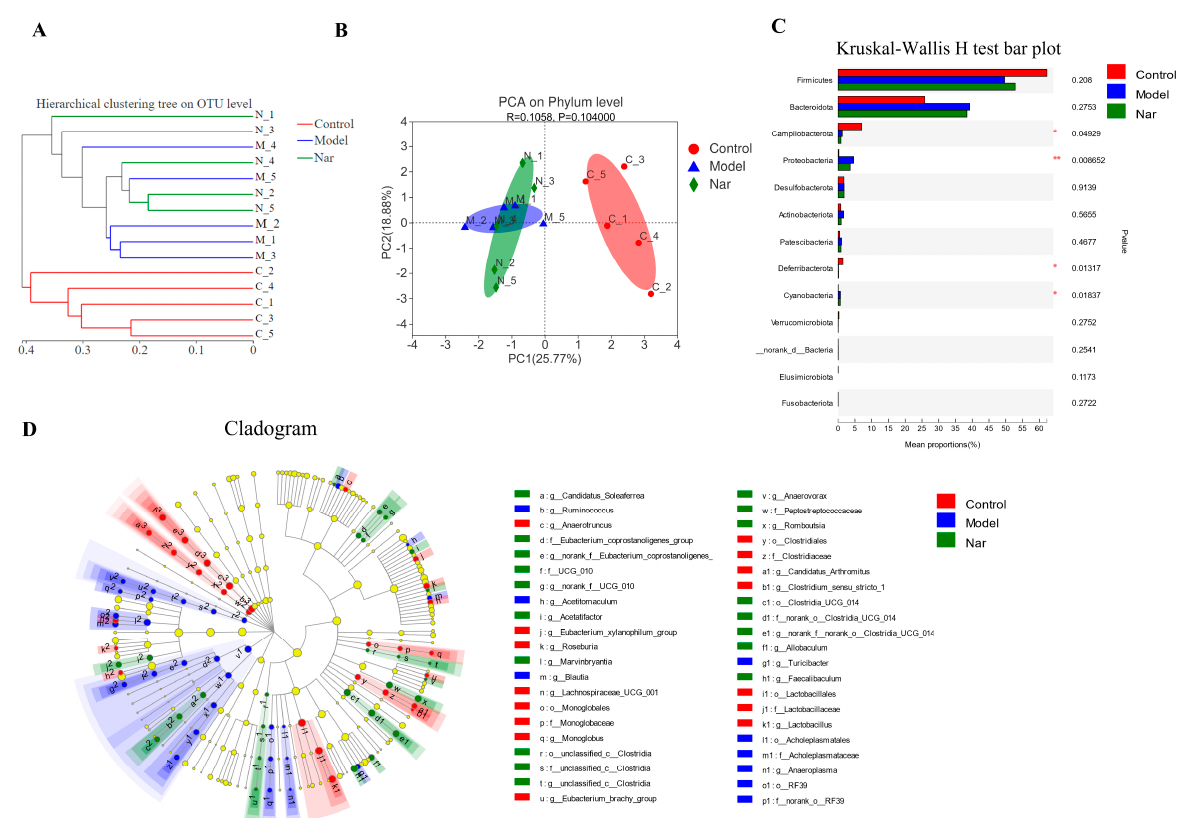
Figure 7. Species difference analysis on the gut microbiota in DSS-induced colitis mice. ( A ) Cluster dendrogram of the three groups on OUT level. ( B ) PCA analysis of variation on phylum level. ( n = 5). ( C ) The Kruskal-Wallis H test was used to compare the species of intestinal flora in different groups. This figure is the result at the level of phylum classification. * p < 0.05 and ** p < 0.01, compared with the control group. ( D ) The LEfSe dendrogram showed the phylogenetic distribution of associated colonic microorganisms in three groups of